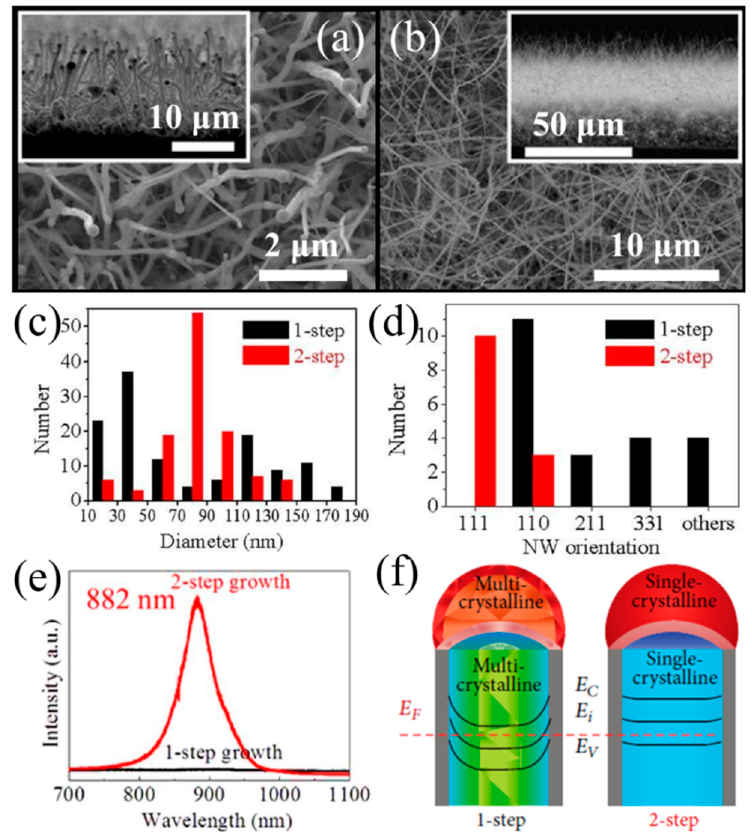
Figure 6. Comparison of the single-step and two-step growth method. ( a , b ) SEM images of the single-step and two-step grown NWs. Insets: the corresponding cross-sectional SEM images illustrating the length of the NWs. ( c , d ) Diameter distribution and NW growth orientation statistic of GaAs NWs grown by the 12 nm thick Au catalyst. ( e ) Room temperature photoluminescence (PL) spectra, showing a good crystal quality of the two-step grown NWs. ( f ) Cross-sectional view of NWs with the corresponding crystal quality and equilibrium energy band diagram at the zero gate bias. Adapted with permission from [121].